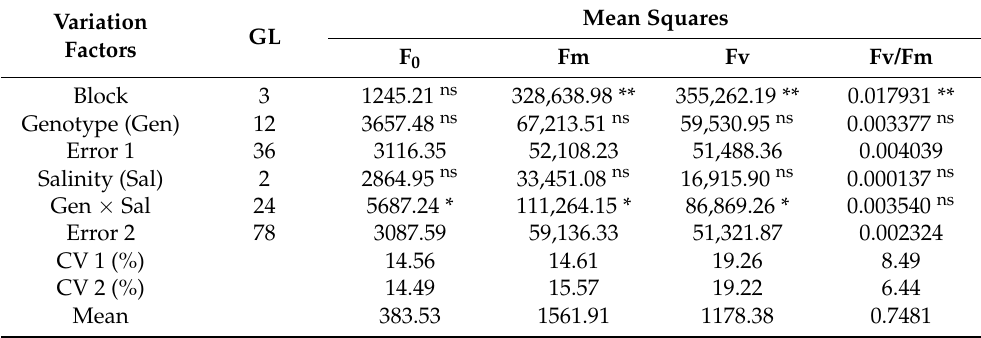
Table 7. Summary of analysis of variance of chlorophyll a fluorescence analysis after dark stage, initial fluorescence (F0), maximum fluorescence (Fm), variable fluorescence (Fv), and quantum efficiency of photosystem II (Fv/Fm), of combinations of ‘Tahiti’ acid lime ( Citrus × latifolia (Yu. Tanaka) Tanaka) with 13 rootstocks under water salinity, at 720 days after the onset of saline water irrigation. Mean Squares Variation GL Factors